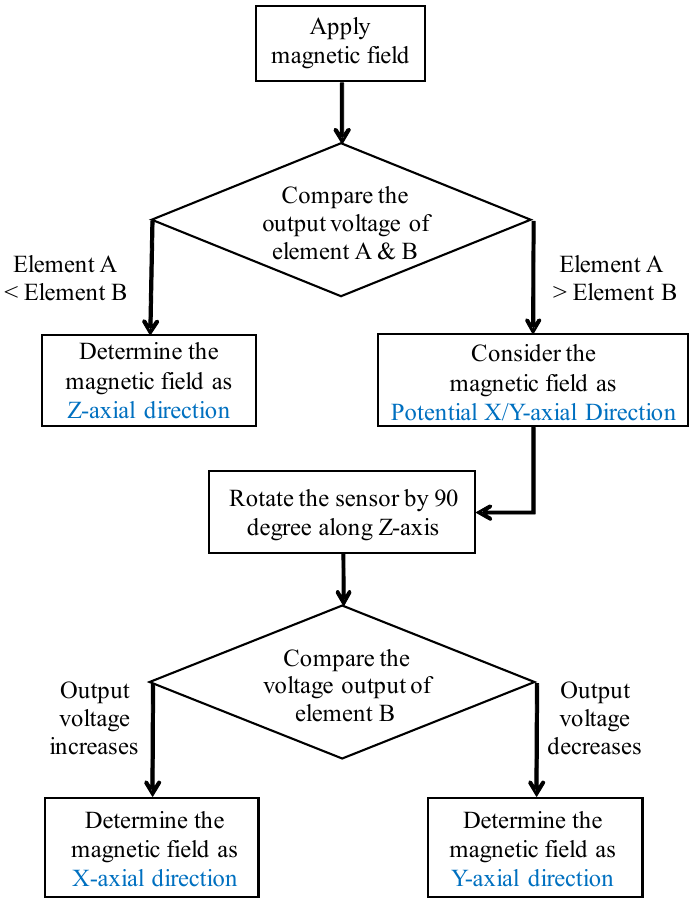
Figure 10. The criterion to determine the direction of any unknown magnetic field vector applied to the sensor.